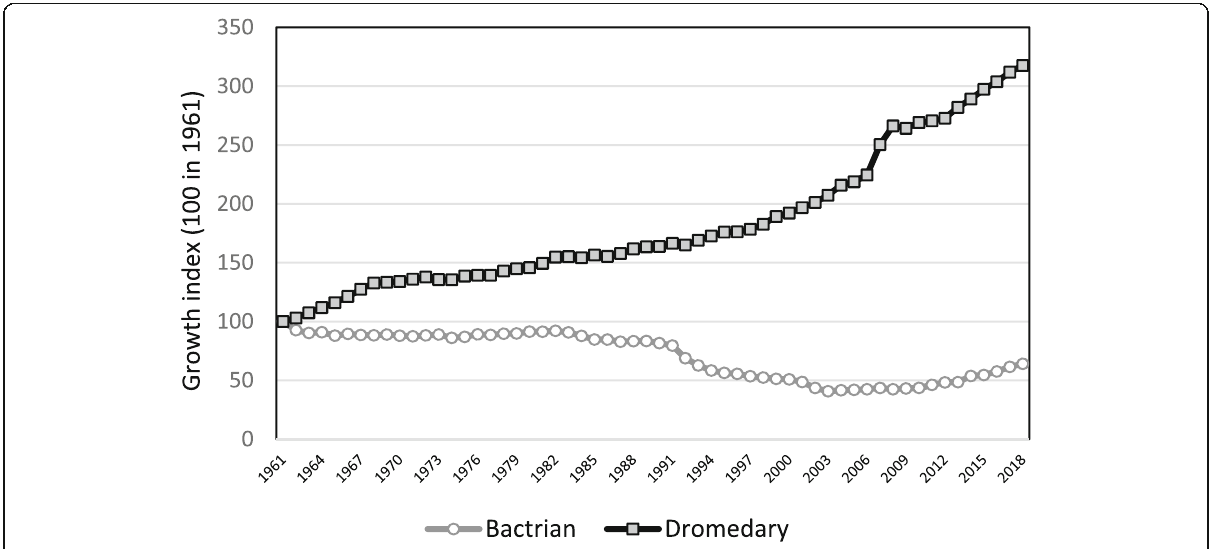
Fig. 19 Comparative demographic changes between Bactrian and dromedary camels at world level 1961 – 2018 (source: FAOstat